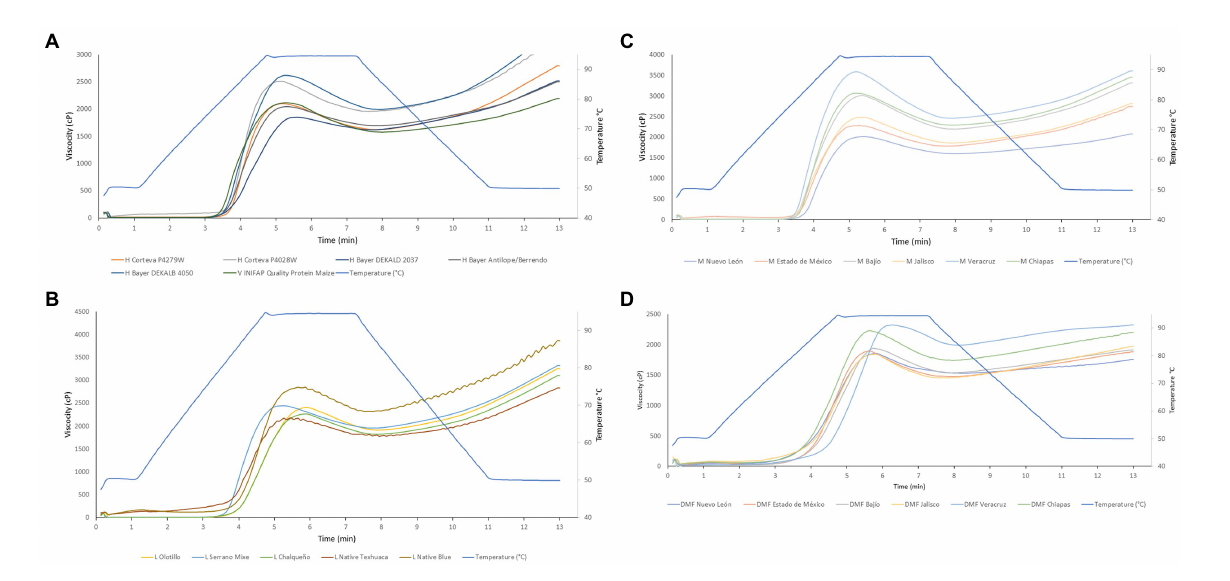
FIGURE 1 Rapid Visco Analyzer (RVA) curves of pasting properties of nixtamalized maize masa and flours from different genotypes. (A) High producing hybrids and varieties. (B) Landraces. (C) Hybrid mixtures. (D) Dry masa flours. Each curve was the average of two analyses. Different scales were used for each graph to differentiate values among samples. H = Hybrid maize; V = Maize varieties; M = Hybrid mixtures; DMF = Dry masa